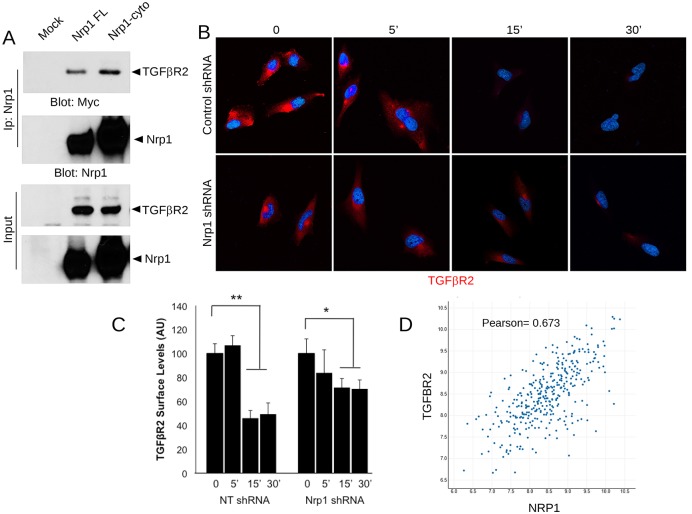
Nrp1 interacts with TGFβR2 to promote receptor internalization in GBM cells.(A); HEK 293T cells were transfected with myc-tagged TGFβR2 and full-length Nrp1 or Nrp1 lacking the cytoplasmic domain. Protein-protein interactions were then analyzed in detergent-soluble lysates by co-immunoprecipitation. Note that TGFβR2-myc interacts with Nrp1 independently of the Nrp1 cytoplasmic tail. (B); LN229 GBM cells expressing control shRNAs (top) or Nrp1 shRNAs (bottom) were treated with TGFβ1 for varying times (indicated along top of panel). Cell surface levels of TGFβR2 protein were analyzed by immunofluorescently labeling fixed, non-permeabilized cells with anti-TGFβR2 antibodies. (C); Quantitation of Nrp1-dependent TGFβR2 protein internalization in LN229 cells following TGFβ1 treatment. Error bars represent standard deviation, *p<0.05 for control shRNA samples (time 0) versus 15 and 30 minutes samples, **p<0.01 for Nrp1 shRNA samples (time 0) versus 15 and 30 minute treatments. (D); Two gene scatter plot showing coincident NRP1 and TGFBR2 RNA expression in TCGA GBM samples. The results are statistically significant based on a Pearson’s coefficient of 0.673. All error bars represent standard deviation.